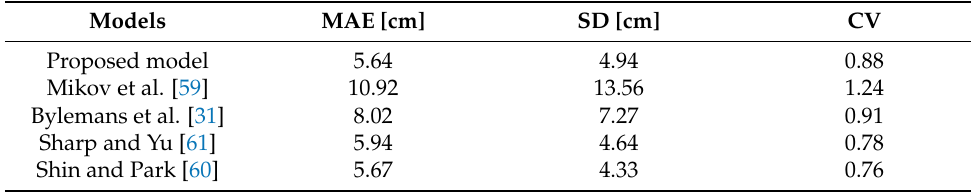
Table 3. Overall MAEs, SDs, and CVs of stride length estimation.